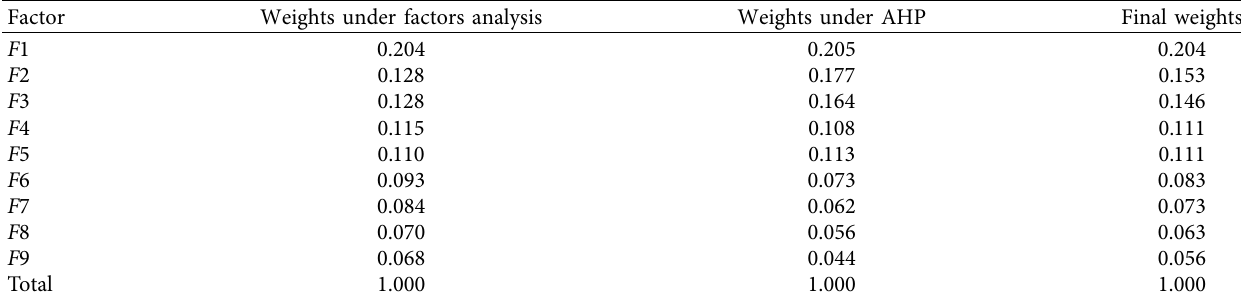
Table 9: Factor weights.